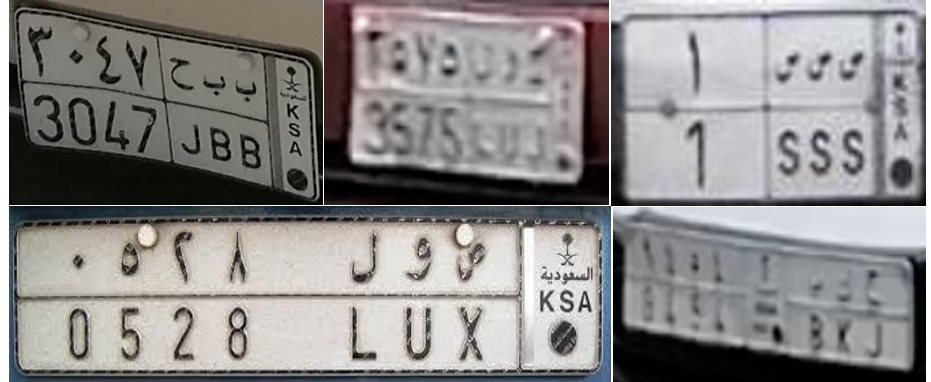
Figure 5. Sample images from the dataset used for single-character detection showing images of different quality and angle views and two different aspect ratios of Saudi license plates using different fonts. We intentionally kept low resolution images, considering that this is the type of resolution expected in real